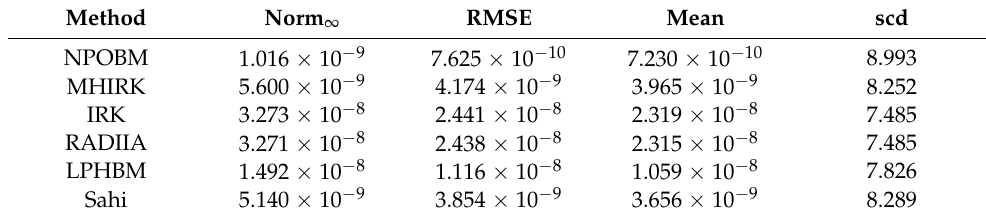
Table 14. Numerical results for Problem 4 with NS = 2 7 where x ∈ [ 0,10 ] .